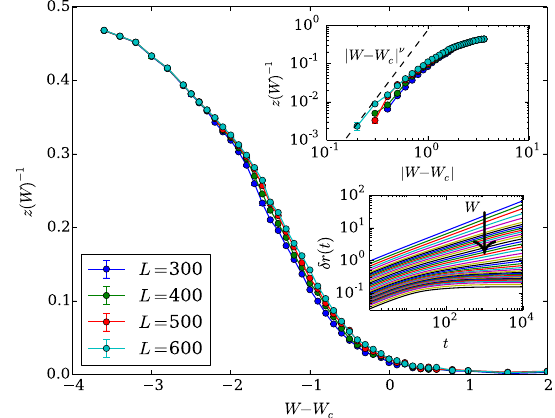
FIG. 3. Energy transport near the transition. In the delocalized phase ( W < W c ), excess energy initially localized near the origin spreads to a distance δ r ∼ t 1 =z in time t (bottom inset). The dynamical critical exponent z diverges continuously from the delocalized side of the transition and vanishes inside the quantum critical glass phase (main panel). The numerical results are consistent with z diverging as j W − W c j − ζ with ζ ¼ ν (top